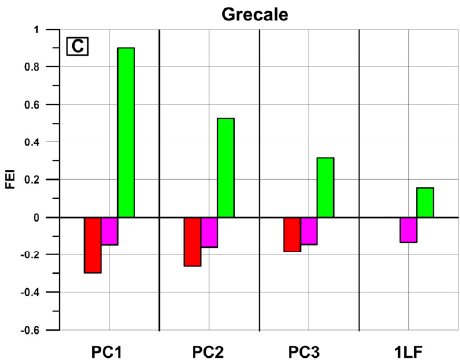
Figure 5. FEI between harbour configurations in Scirocco ( A ), Libeccio ( B ) e Grecale ( C ) conditions.